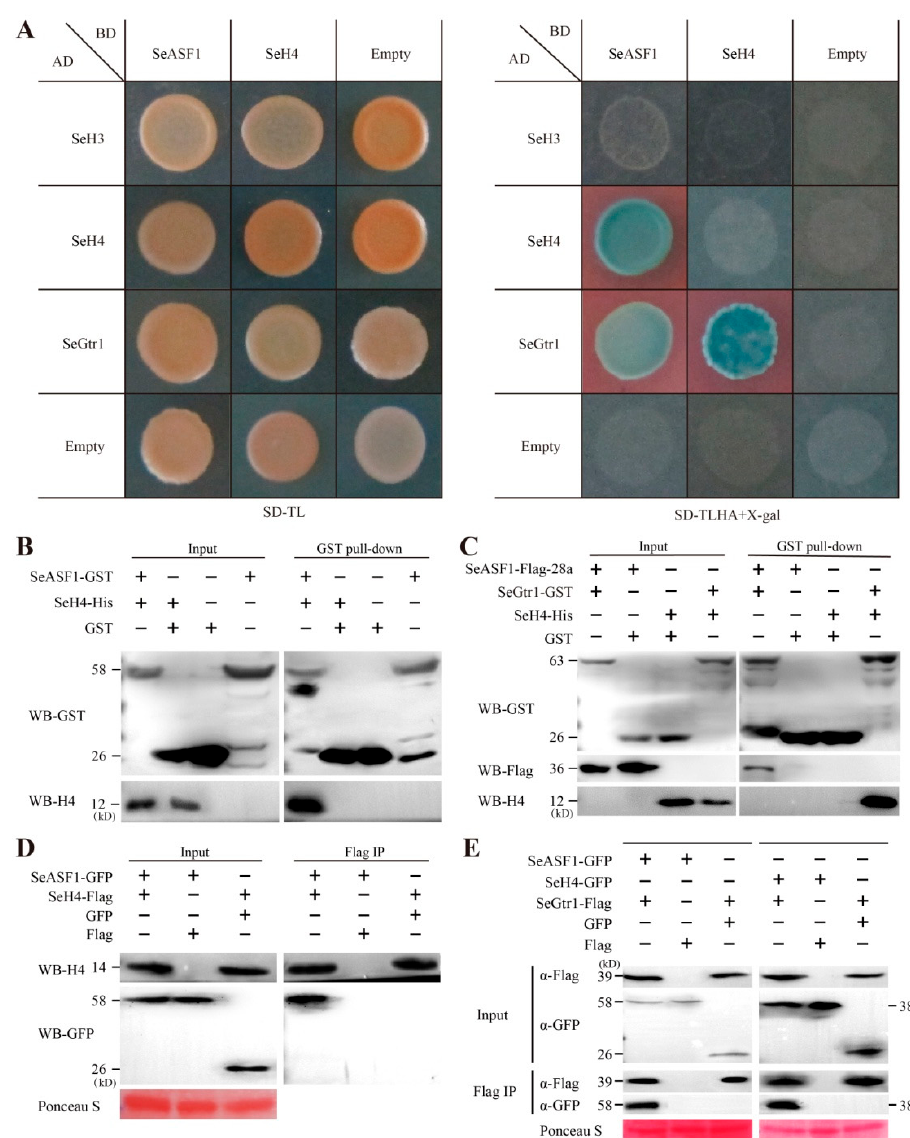
assigned to value 1.0. Two Seasf1 deleted mutants were Se ∆ asf1 -0 and Se ∆ asf1 -5, two complemented transformants were Se ∆ asf1 :: Seasf1 -1 and Se ∆ asf1 :: Seasf1 -2. Two SeH4 -silenced lines were Si SeH4 -T8 and Si SeH4 -T20. Two Segtr1 -silenced lines were Si Segtr1 -T63 and Si Segtr1 -T66, two OE Segtr1 lines were OE Segtr1 -T3 and OE Segtr1 -T8. The Actin in S. eturmiunum was used as endogenous control. The bars indicated statistically significant differences (ANOVA; ** p < 0.01).